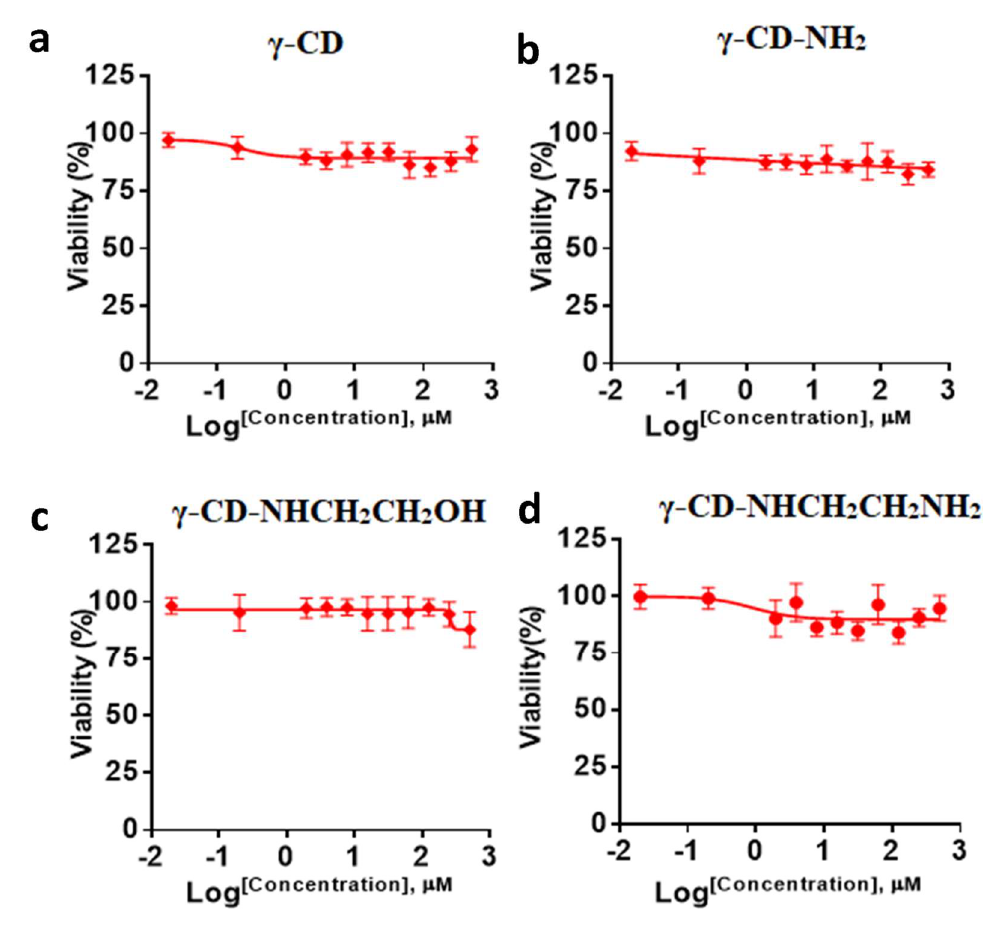
Figure 7. The dose–response curves of ( a ) γ-CD, ( b ) γ-CD-NH 2, ( c ) γ-CD-NHCH 2 CH 2 OH, and ( d ) γ-CD-NHCH 2 CH 2 NH 2 against HDF cells.